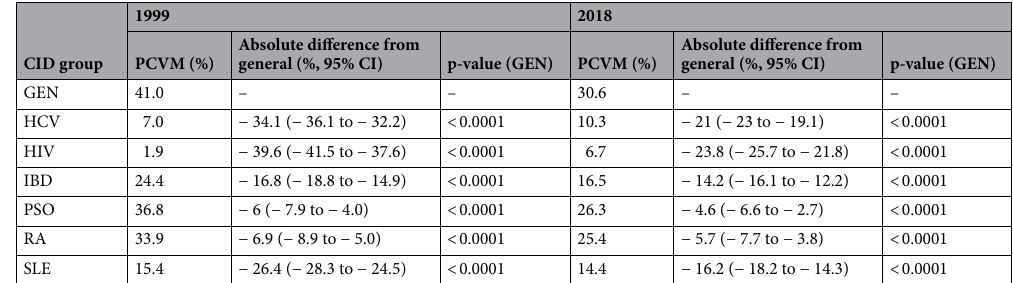
Table 1. Ordinary least squares modeling of proportionate cardiovascular mortality in 1999 vs. 2018 by condition. GEN General population, HCV Chronic Hepatitis C Virus, ICD-10 code B18.2, HIV Human immunodeficiency virus, ICD-10 codes B20–24, IBD Inflammatory bowel disease, ICD-10 codes K50–51, PSO Psoriasis, ICD-10 code L40, RHA Rheumatoid Arthritis, ICD-10 codes M5–M6, SLE Systemic lupus erythematous, ICD-10 code M32. All PCVM (and resulting operations) reported as percent. p-values represent test of difference between the general population and each individual CID group within the same year (1999 or 2018).